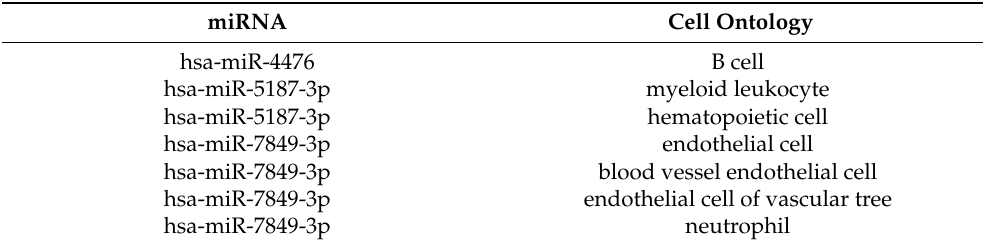
Table 6. MicroRNA regulating the expression of TMPRSS2 and BSG genes and showed expression in immune and endothelial cells. According to